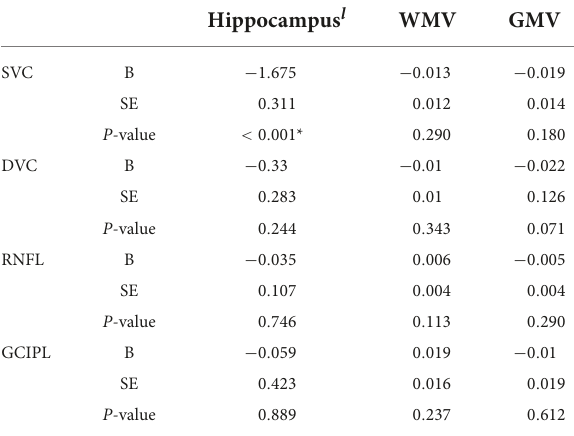
TABLE 3 Correlations between SS-OCT/OCTA parameters and brain MRI